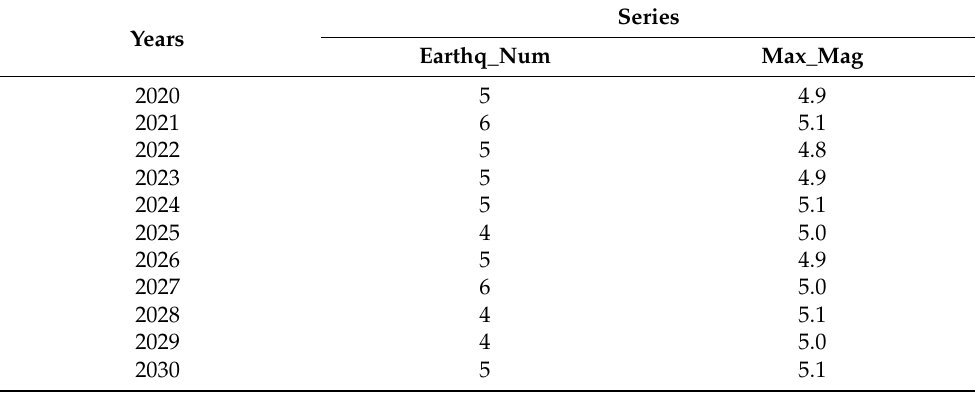
Table 4. Forecasted annual earthquake number and annual maximum magnitude time series